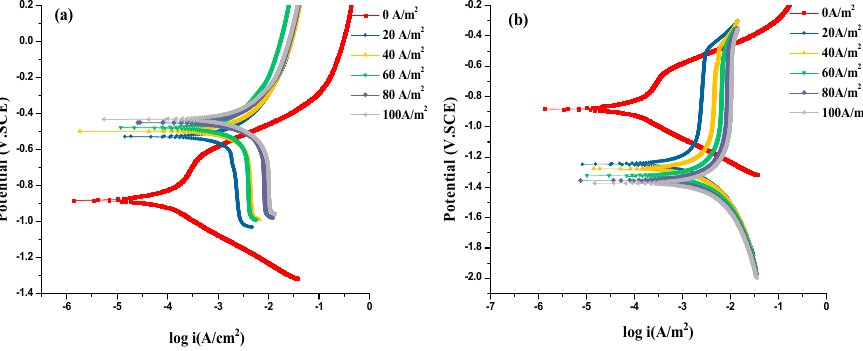
Figure 5. The polarization curves of 3PE-coated X80 steel under DC anode ( a ) and cathode ( b ) polarization. Table 1. The electrochemical parameters of 3PE-coated X80 steel samples under DC anode polarization at different DC current